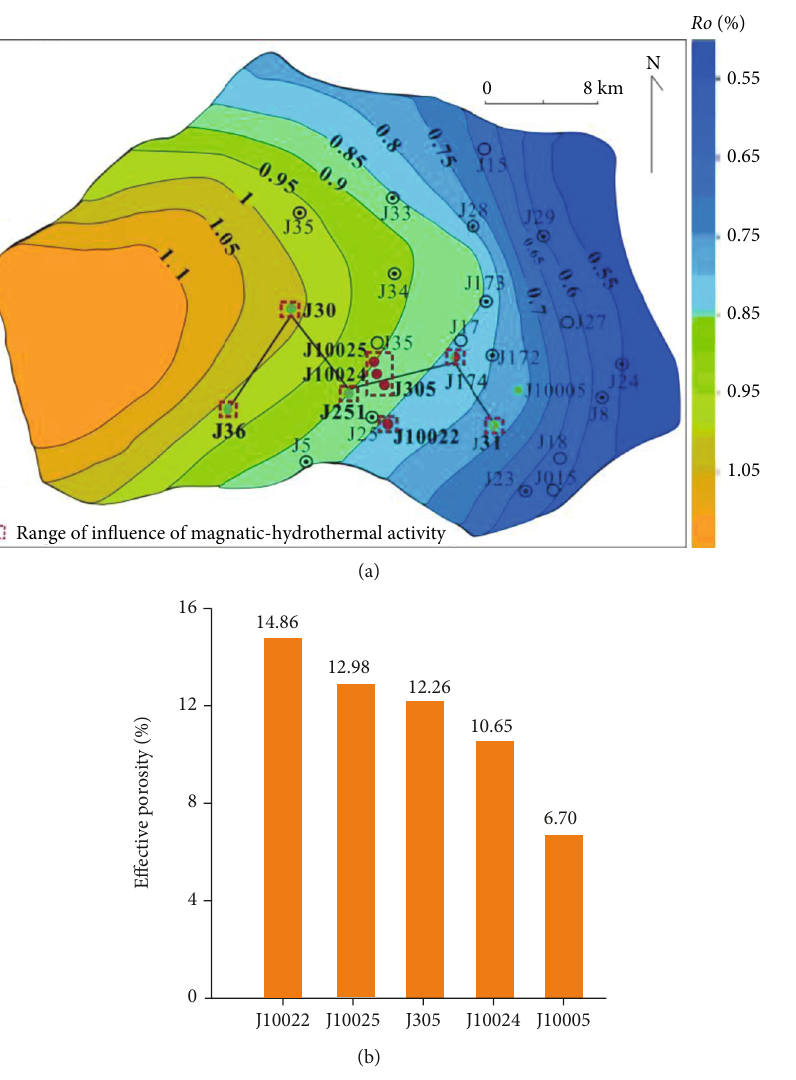
fi ed from Qiu et al., 2016) (a). E ff ective porosity plane distribution characteristics of the Figure 17: R o of the whole sweet spot section (modi lower sweet spot section of the Jimsar Depression Luchaogou Formation